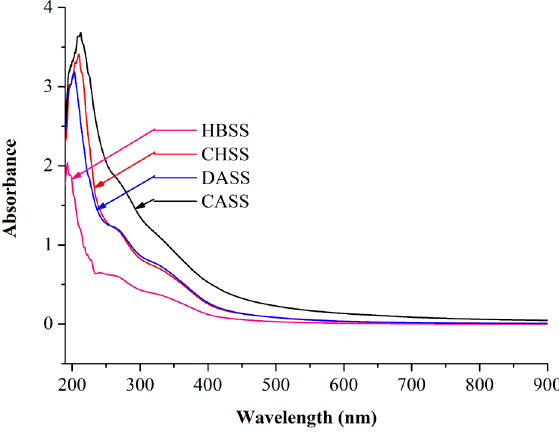
Figure 1. Ultraviolet scan of mulberry leaf polysaccharides (MLPs) over the range of 190–900 nm.